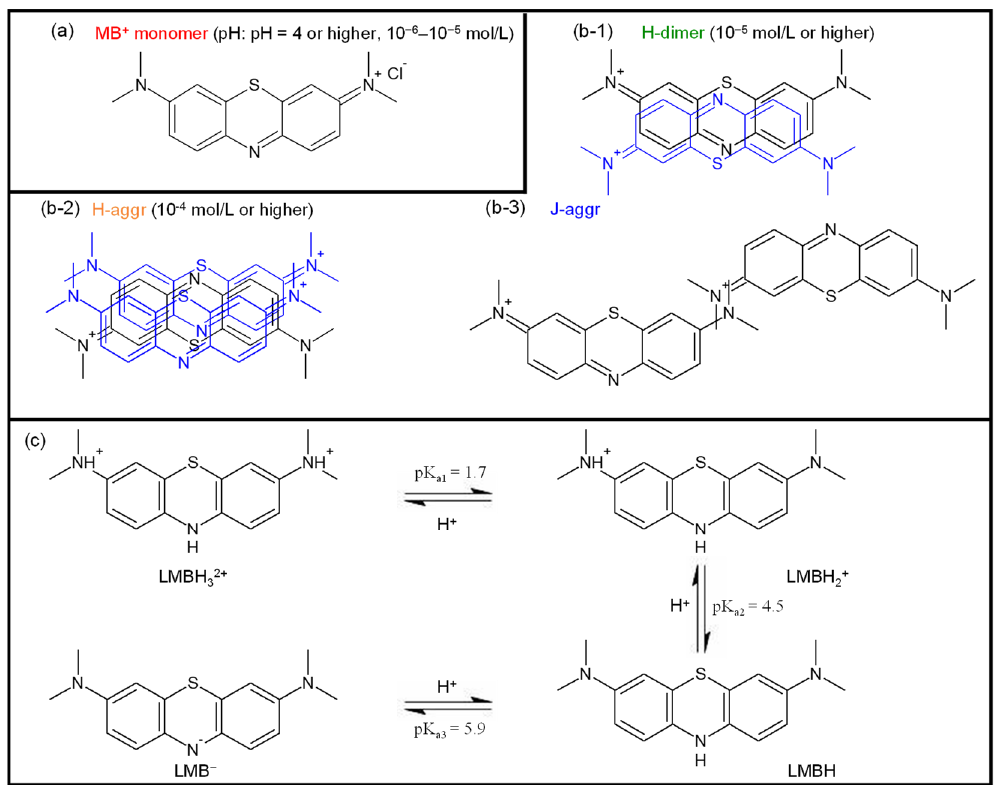
Figure 8. Chemical structures in aqueous solution of ( a ) MB + monomer, which generates 1 O 2 , ( b-1 – b-3 ) MB + aggregation states at the different concentrations and ( c ) acid-based equilibria of LMB in water.